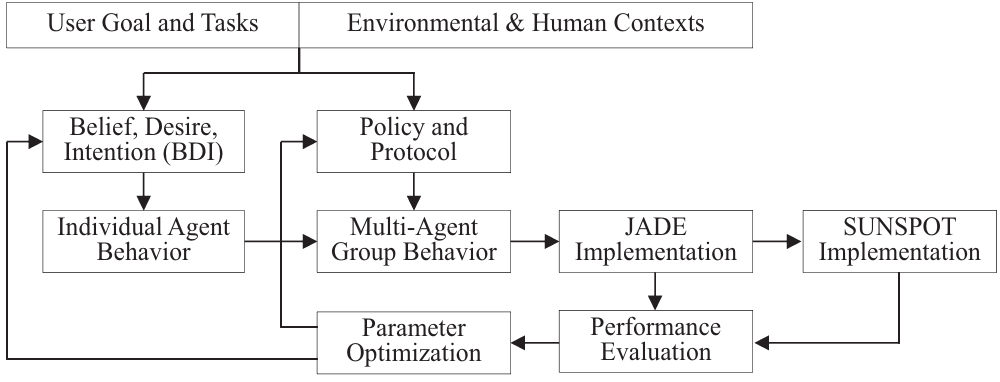
Figure 1. The proposed design and evaluation procedure of multi-agent systems for smart house